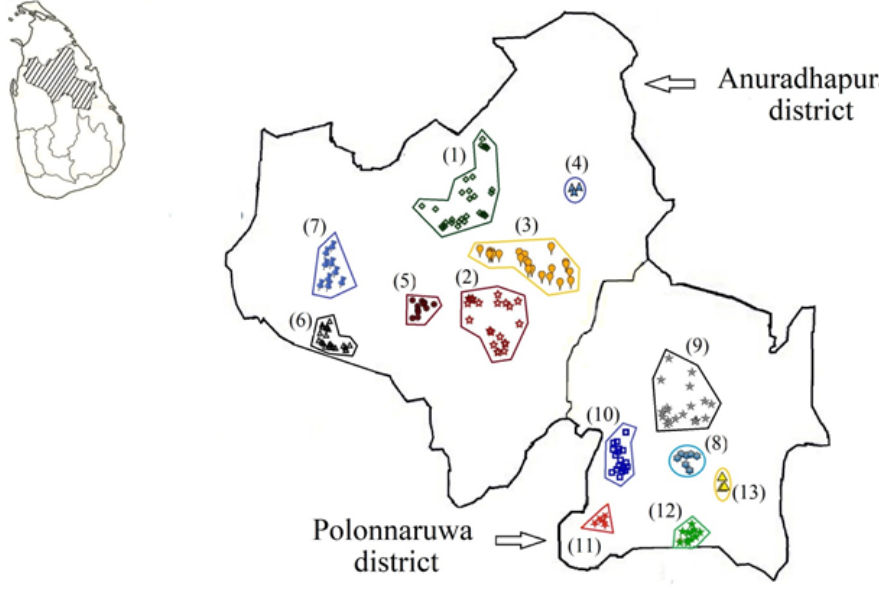
Figure 1: Map of the study area and sampling locations in Anuradhapura and Polonnaruwa Districts of North Central Province